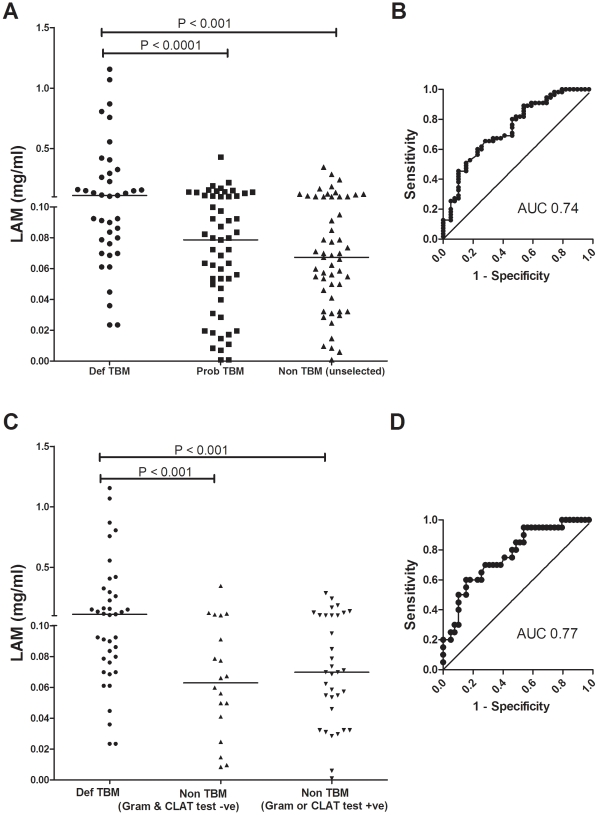
Lipoarabinomannan antigen performance outcomes using CSF when comparing definite, probable and non-TB meningitis groups.(A) shows the definite TBM compared with the unselected non-TB meningitis group and the corresponding ROC curve (B). Responses when the non-TB meningitis group was stratified by rapid test results (Gram stain or CLAT positive, versus, Gram stain and CLAT both negative) are shown in (C) with the corresponding ROC curve (D). Note (C) for the sake of clarity does not show the probable TB meningitis group.